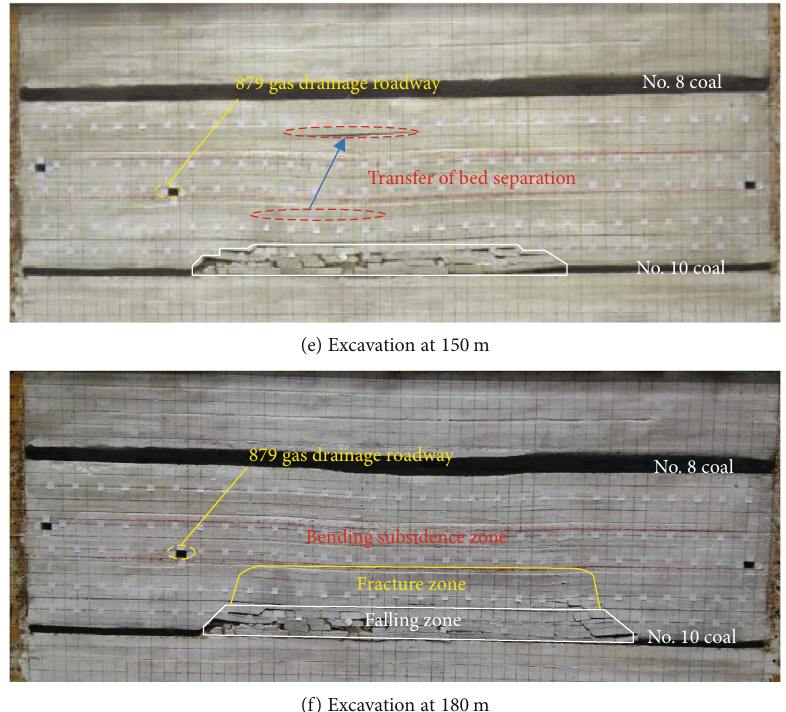
Figure 4: Movement characteristics of overlying strata during mining.